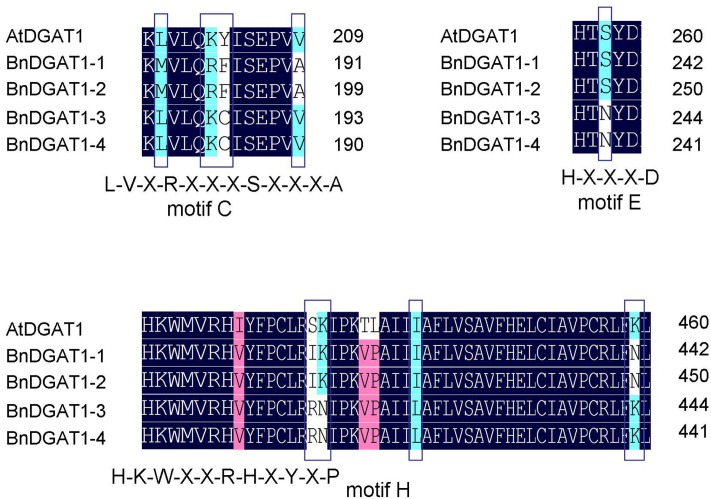
Differentiation of BnDGAT1s on motifs C, E, and H. Sequence alignment of deduced BnDGAT1 and AtDGAT1 amino acid sequences were performed by using DNAMAN. Motifs of an acyl-CoA binding signature spanning active site catalytic residues (motif A), a thiolase acyl-enzyme intermediate binding motif (motif B), a typical targeting site of members of the sucrose non-fermenting (SNF)-related protein kinase 1 (SnRK1) family (motif C), a leucine zipper motif (motif D), motifs common to most annotated DGAT1s (motifs E and F), a fatty acid binding protein signature spanning residues (motif G), and a DAG/phorbol ester binding motif (motif H) were identified. Only motifs C, E, and H show differentiations among BnDGAT1s.